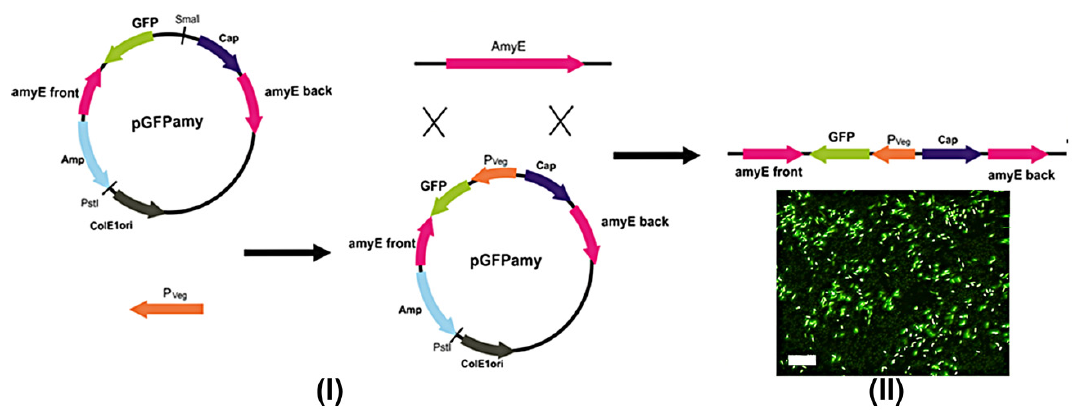
Figure 7. ( I ) Construction of the gene engineering plasmid pGFPamyPveg for B. subtilis 26D